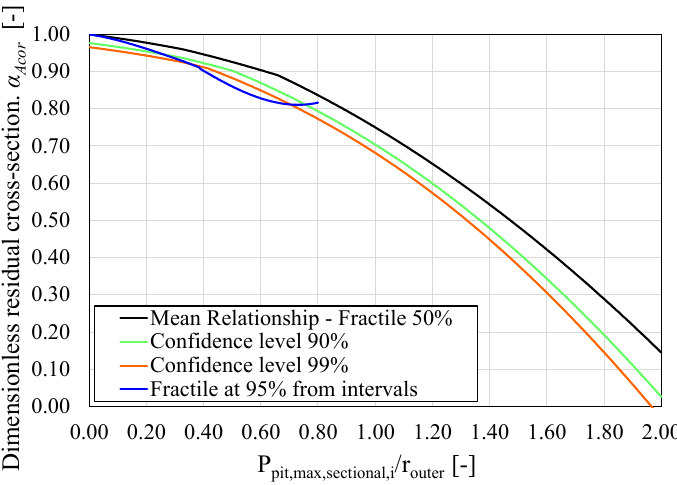
Figure 10. Different trend of the residual cross-section parameter α Acor for the different confidence levels of the relationship relating Ω i measurements and P pit,max,sectional,i / r outer values.